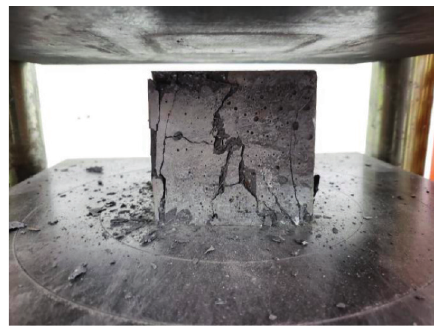
Figure 8: Failure condition of compressive